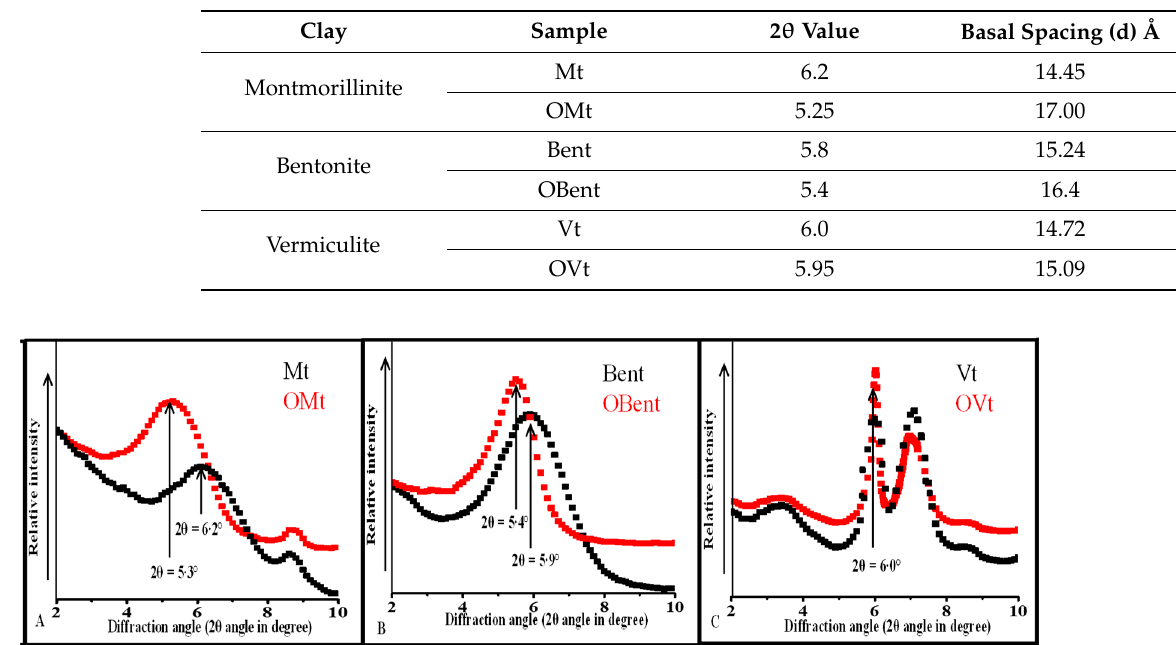
Table 2. XRD diffraction peak and basal spacing of clay and modified clay.